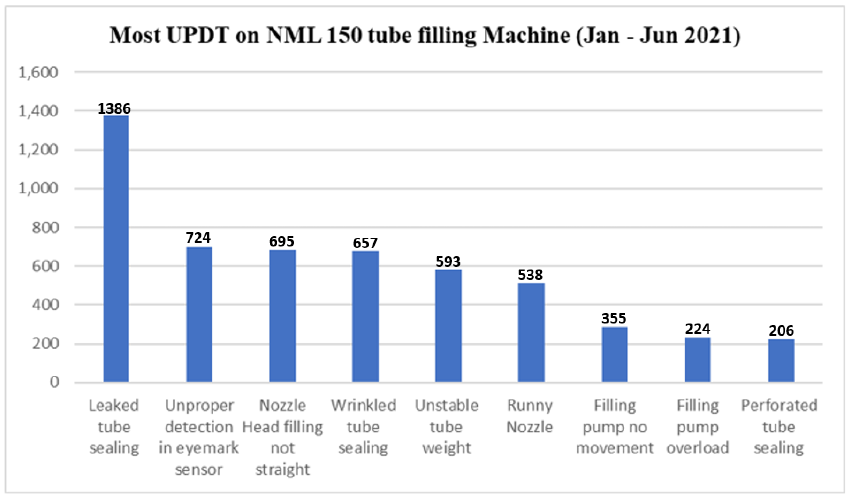
Figure 3. Machine historical data of unplanned downtime for six months (January 2021 – June